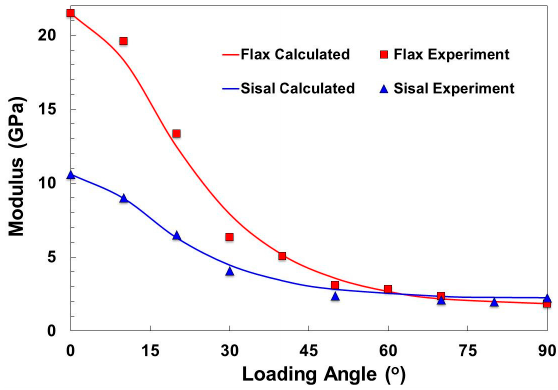
Figure 5. The composite modulus at various loading angles compared to values fitted using Equation (3).